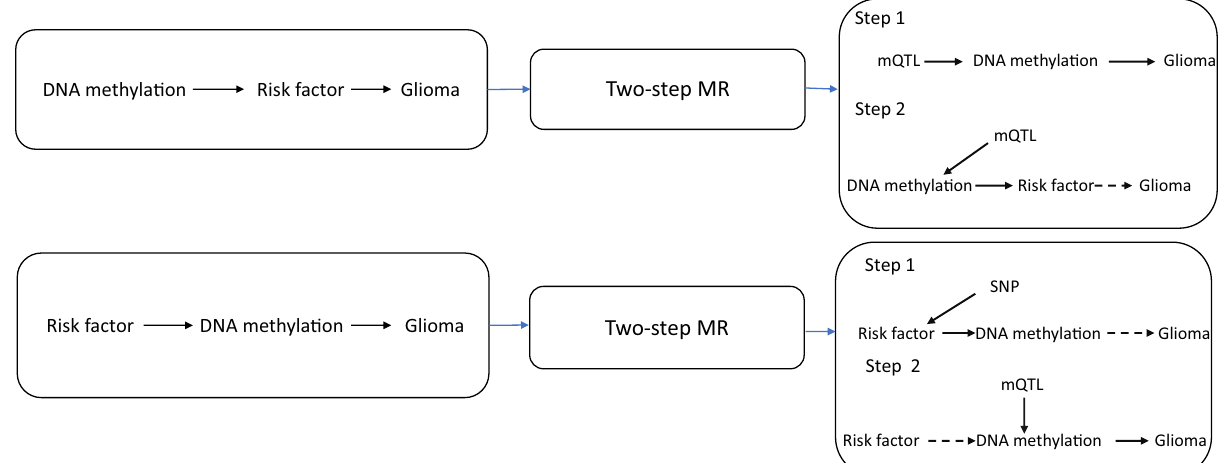
Figure 1. The research questions and how they link to causal pathways in glioma development. An overview displaying the objective of each analysis, the techniques and causal mechanisms examined. DNAm DNA methylation, SNP single nucleotide polymorphism, mQTL methylation quantitative trait